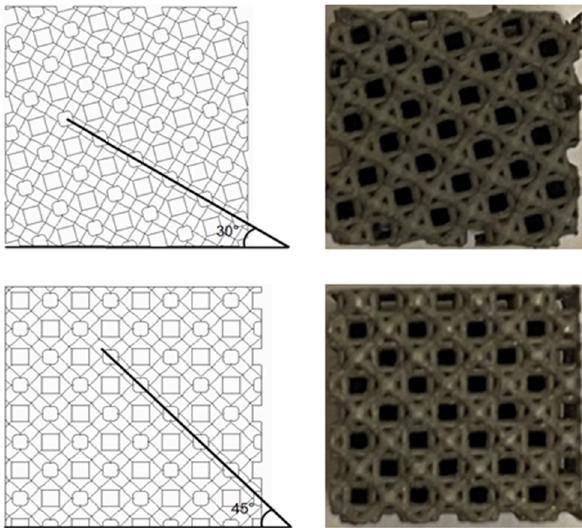
Figure 20: The 2 mm unit cell with 0.6 mm edge diameter is molded at di ff erent